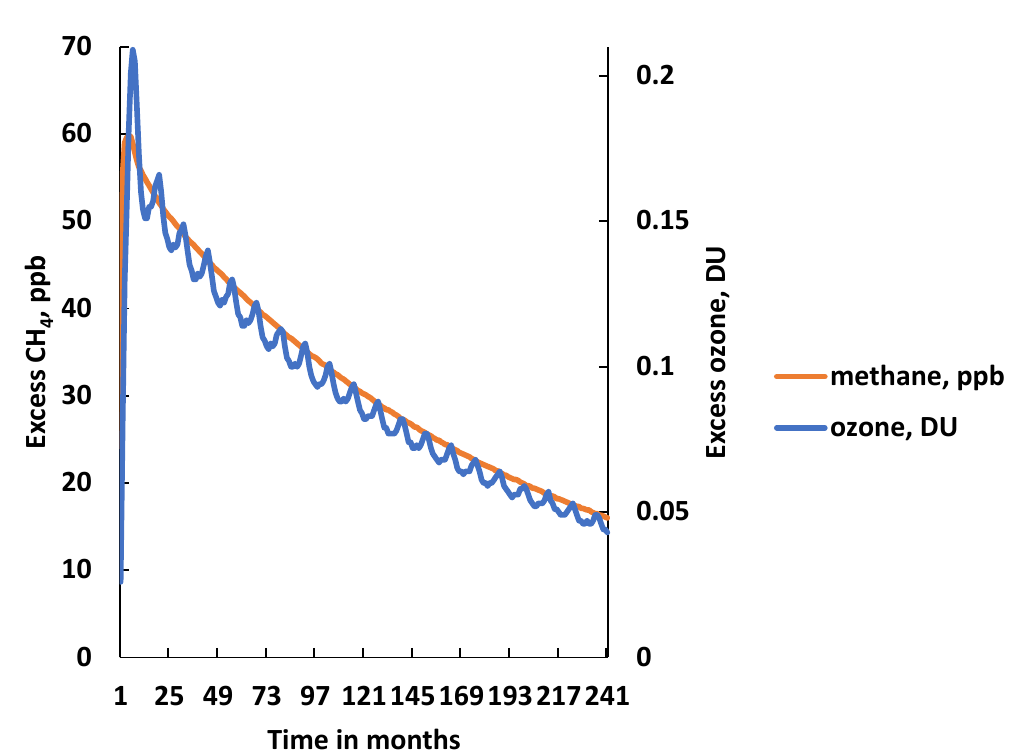
Figure 2. Time development of the excess global mean CH 4 mixing ratio and the excess global mean O 3 column in Dobson Units following the addition of a 149 Tg CH 4 emission pulse.